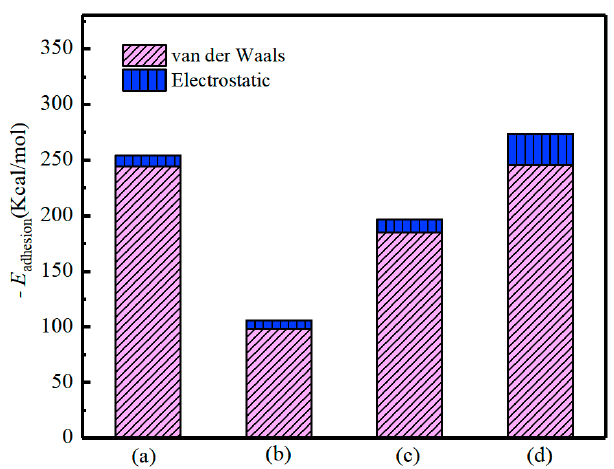
Figure 11. Illustration of asphalt-aggregate interaction energy and its component: ( a ) granite/SCA- asphalt model, ( b ) granite-asphalt model, ( c ) basalt-asphalt, and ( d ) limestone-asphalt.